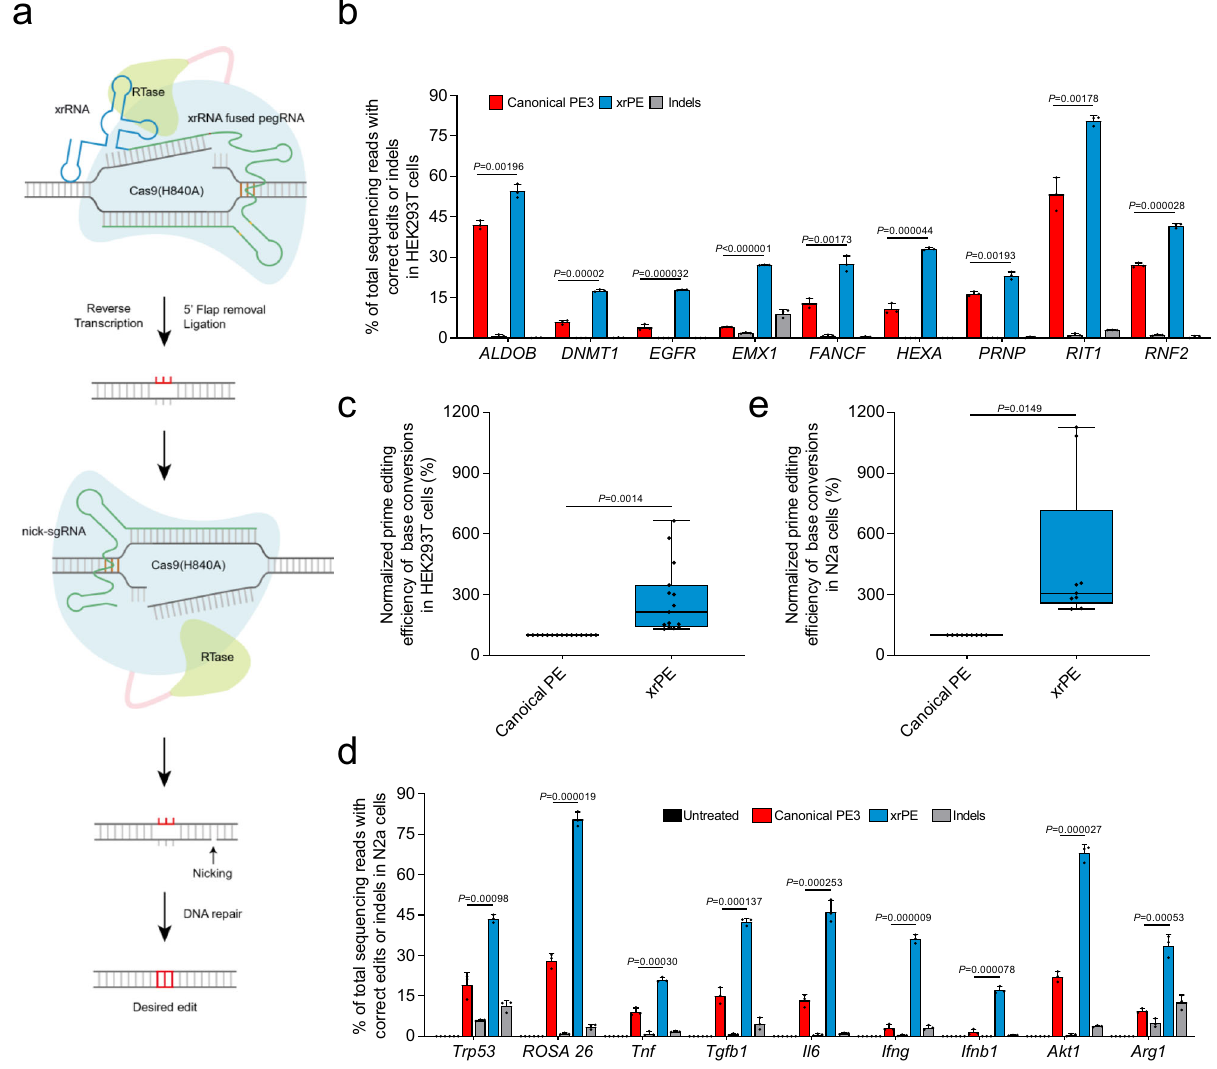
Fig. 3 The xrPE shows enhanced performance for base conversions in multiple cell types. a An illustration for the xrPE platform. The joining of an